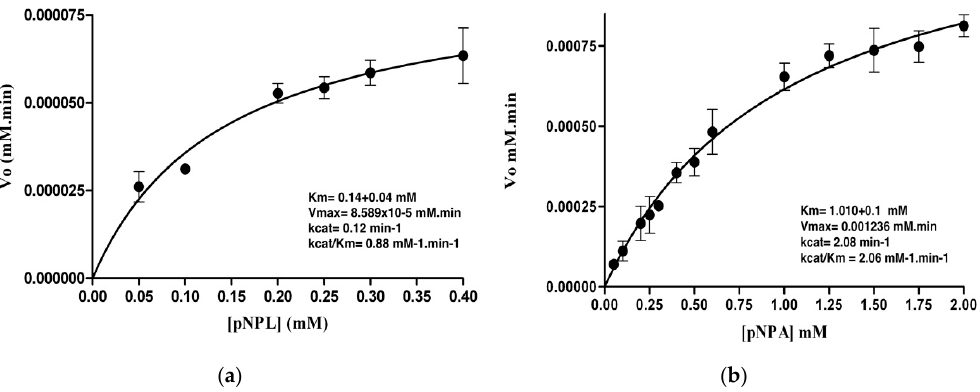
Figure 6. E ff ect of substrate concentration [S] on the enzymatic rate (V o ) of LvFSH, using p -nitrophenyl esters. ( a ) A 0.05–0.2 mM concentration range was assayed for p -nitrophenyl laureate ( p -NPL, 12-carbon chain); ( b ) a 0.05–2 mM concentration range was assayed for p -nitrophenyl acetate ( p -NPA, 1-carbon chain). Kinetic parameters were calculated. Three replicates were